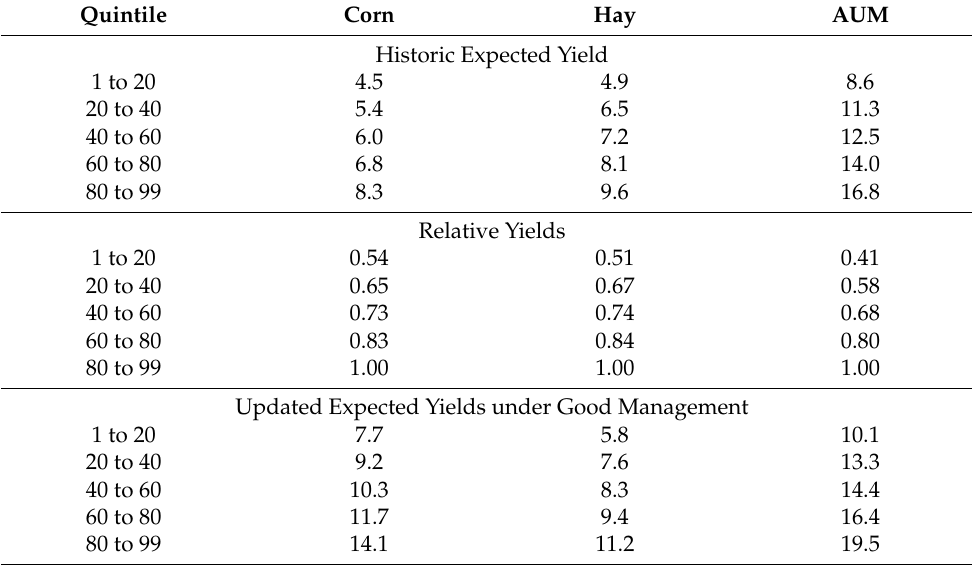
Table 11. Historic, relative, and updated expected corn and mix hay yields (MT · ha − 1 ) and animal unit months of grazing (AUM · ha − 1 ) by quintile from National Soils Information System for West Virginia